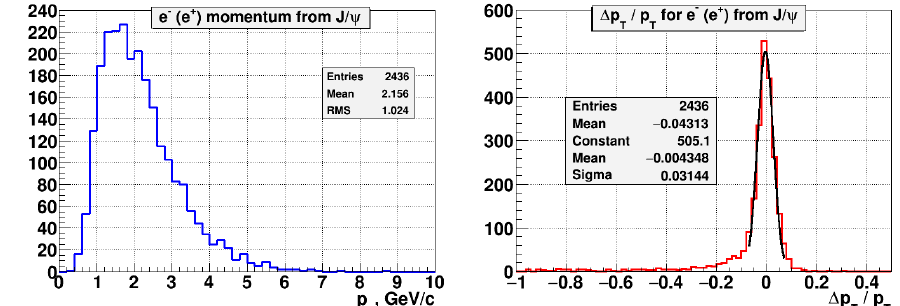
Figure. 3 . Left) Momentum spectrum of electrons and positrons with |η| < 1.5 from J/ψ decays is quite high (~80% for |ψ decays. Right) ∆ηp T /ψ decays is quite high (~80% for |p T distribution for decay products, where ∆ηp T is the difference between reconstructed and true transverse